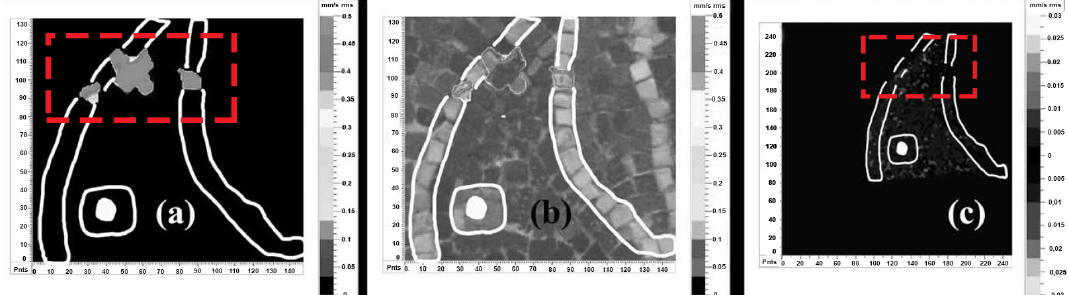
Figure 9. Scanning laser doppler vibrometry (SLDV) results in a custom-built mosaic model. Vibration maps of sample mosaic at 1525 Hz ( a ) a grayscale image representing the vibrational amplitude before restoration, the areas of detached tesserae show higher amplitude, corresponding to lighter shades of grey; ( b ) contour view before restoration; ( c ) amplitude after restoration, showing the more homogeneous distribution of amplitude values along the scanned surface. After Castellini et al. [76] (reprinted with copyright permission).